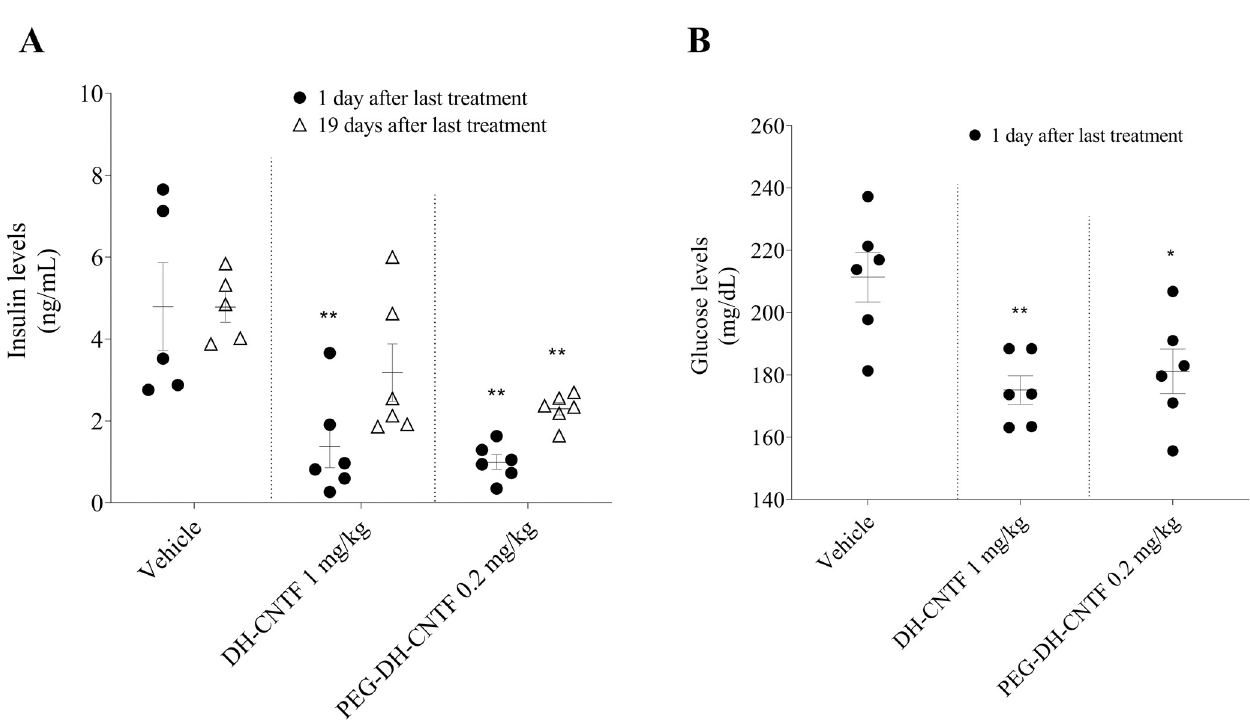
Fig 9. Effect on insulin and glucose in animal used for the weight loss. Statistical analysis (ANOVA test: post-hoc Dunnett’s Multiple Comparison Test) was performed for each group versus vehicle-treated group ( � P < 0.05; �� P < 0.01).